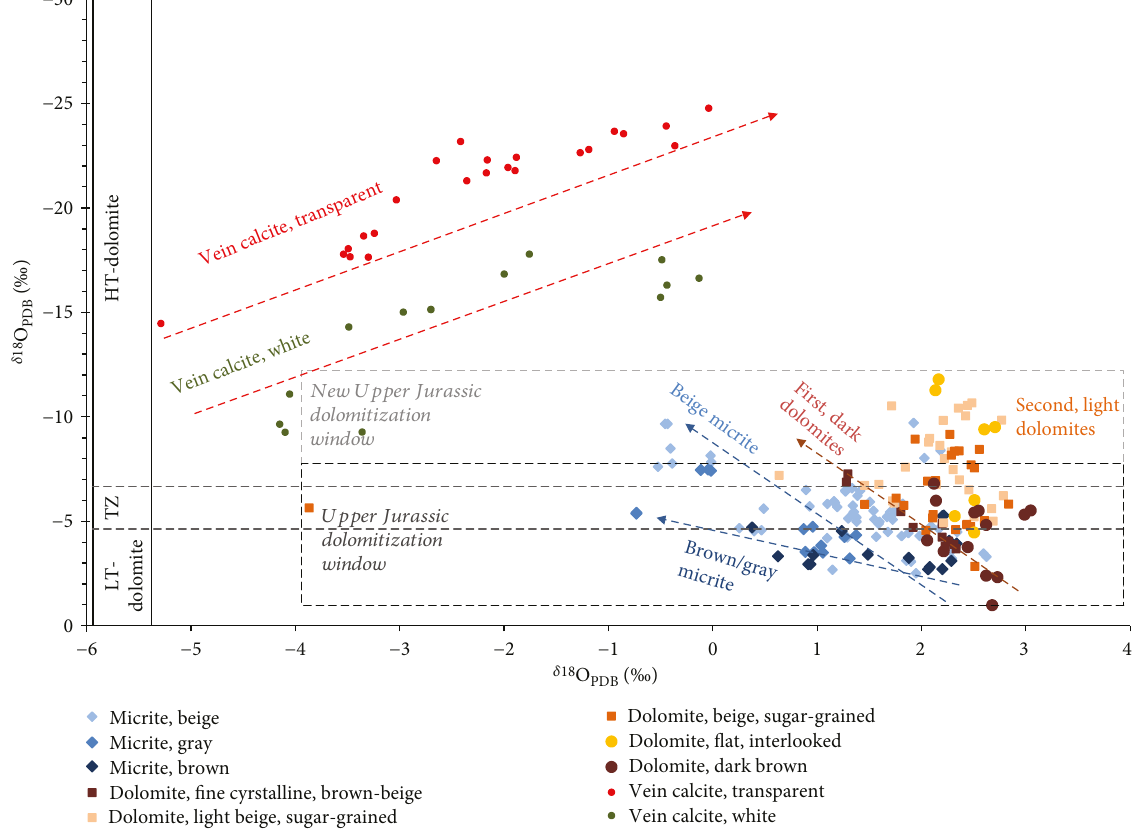
Figure 11: Oxygen and carbon isotopes of Upper Jurassic carbonates from deep wells of the southern Molasse Basin. Dashed window — Upper Jurassic dolomitization window according to Reinhold [17]; the new interpreted Upper Jurassic dolomitization window, LT: low-temperature dolomites; HT: high-temperature dolomites; TZ: transition zone according to Allan and Wiggins [54]. Arrow lines with a trend of increasing meteoric in fl uence according to Liedmann Table 2: Isotope data of di ff erent rock types of the Upper Jurassic from the Molasse Basin.